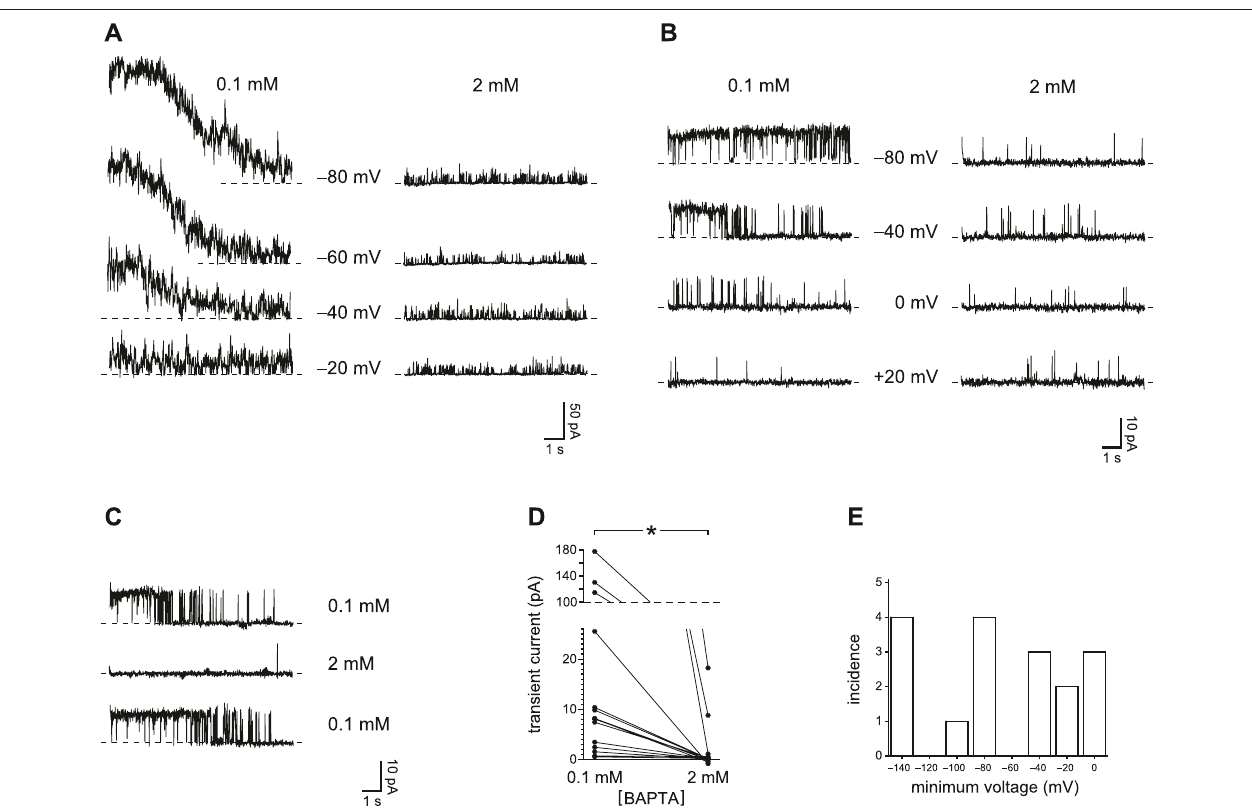
FIGURE 1 | Transient PC2 currents are greater with reduced internal Ca 2+ buffering (0.1 mM BAPTA compared to 2 mM BAPTA). (A) The recordings shown were made with 0.1 mM BAPTA (left) or 2 mM BAPTA (right) at +60 mV immediately following prepulses of 10 s to the voltages shown. Postpulse currents are shown and weremeasured inthesamecilium.This cilium had multiple activePC2 channels, preventing resolution ofsingle-channelevents. Inthisand otherrecordings,the dashed linerepresents thecurrentwhenallPC2 channelswereclosed. (B) Inacilium withjustoneactivePC2channel, thechannelwasalsoactivatedbyprepulsesof10 s to thevoltages shown, and again only at thelower concentration ofBAPTA. Thepostpulsevoltage was+60 mV. (C) Theeffectofreduced Ca 2+ buffering isreversible.A cilium with a single PC2 channel showed transient currents in 0.1 mM BAPTA before and after exposure to 2 mM BAPTA, in which transient currents were not seen. Prepulse and postpulse voltages were − 70 mV and +40 mV,respectively. (D) Paired transient current amplitudes for 15cilia, each tested in both 0.1and 2 mM BAPTA. Voltages were chosen that gave the greatest transient current in 0.1 mM BAPTA. Prepulse voltages ranged from − 140 mV to − 40 mV and postpulse voltages from +40 mV to+80 mV. For a given cilium, the same pair ofvoltages was used in both 0.1 and 2 mM BAPTA. * p < 0.001. (E) Histogram showing the most positiveprepulse voltage suf fi cient to cause a transient current in 0.1 mM BAPTA in each of 17 cilia.